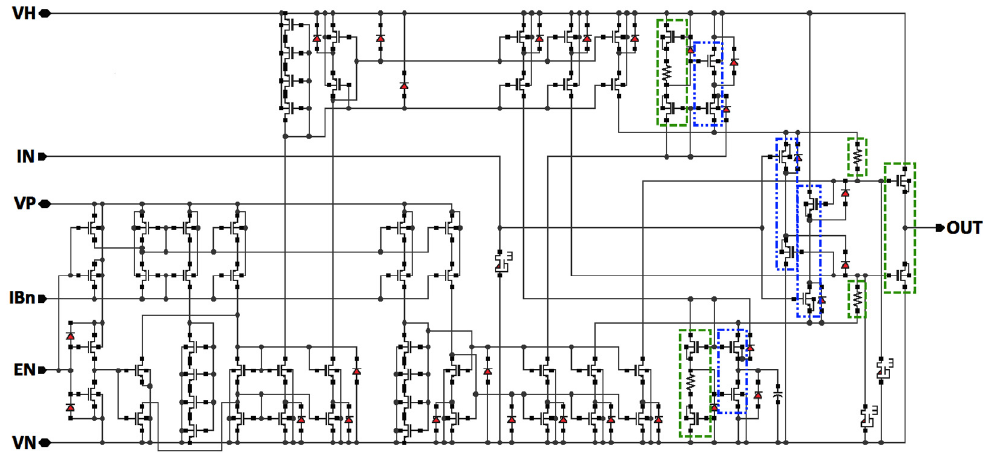
Figure 5. Complete schematic of the scrutinized buffer [9].